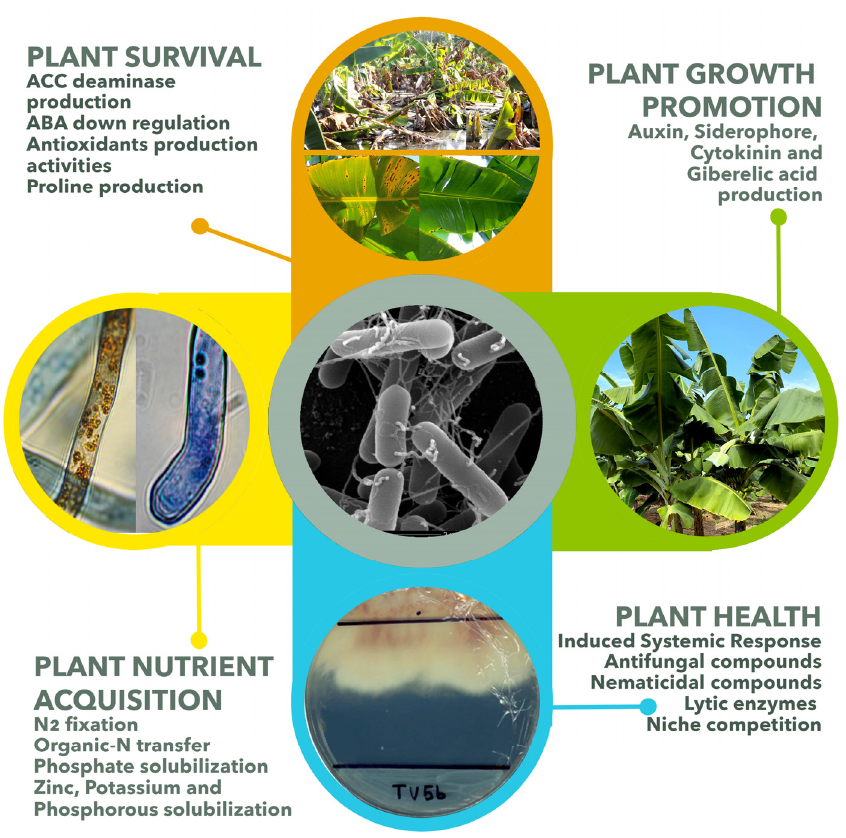
Figure 1. Symbiotic services/functions provided by endophytic probiotic bacteria. Endophyte bacteria can stimulate plant nutrient acquisition and health through different mechanisms and increase plant growth and